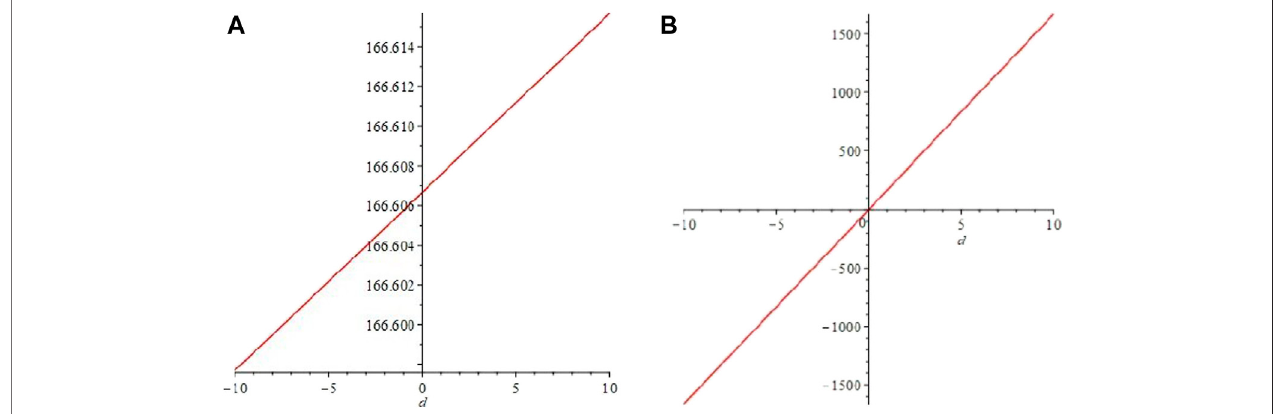
FIGURE 4 | (A) The function image of the derivative of π 2 with respect to d . (B) The relationship between π 2 and d .